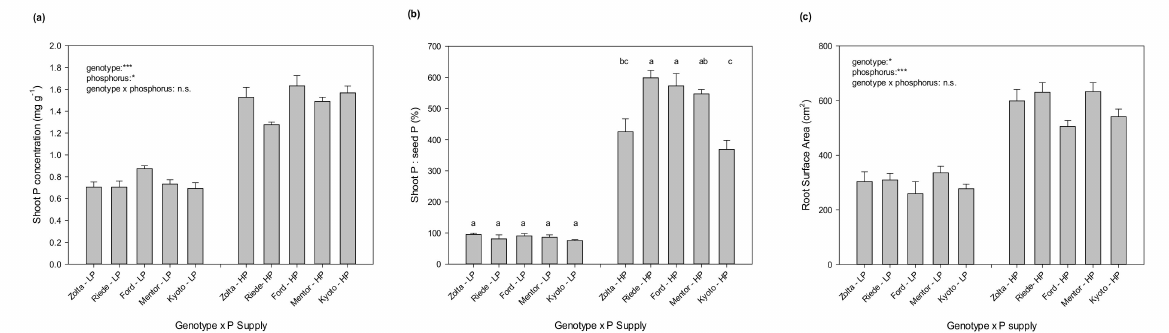
Figure 4. Experiment 2. Shoot P concentration ( a ), ratio of shoot P:seed P in percentage, representing the relative contribution of seed P to shoot P uptake ( b ), and root surface area (RSA) ( c ) of soybean genotypes at LP and HP. * = p < 0.05, *** = p < 0.001, n.s. = not significant. The letters on top of each column represent Tukey’s HSD grouping. Error bars represent standard errors ( n =